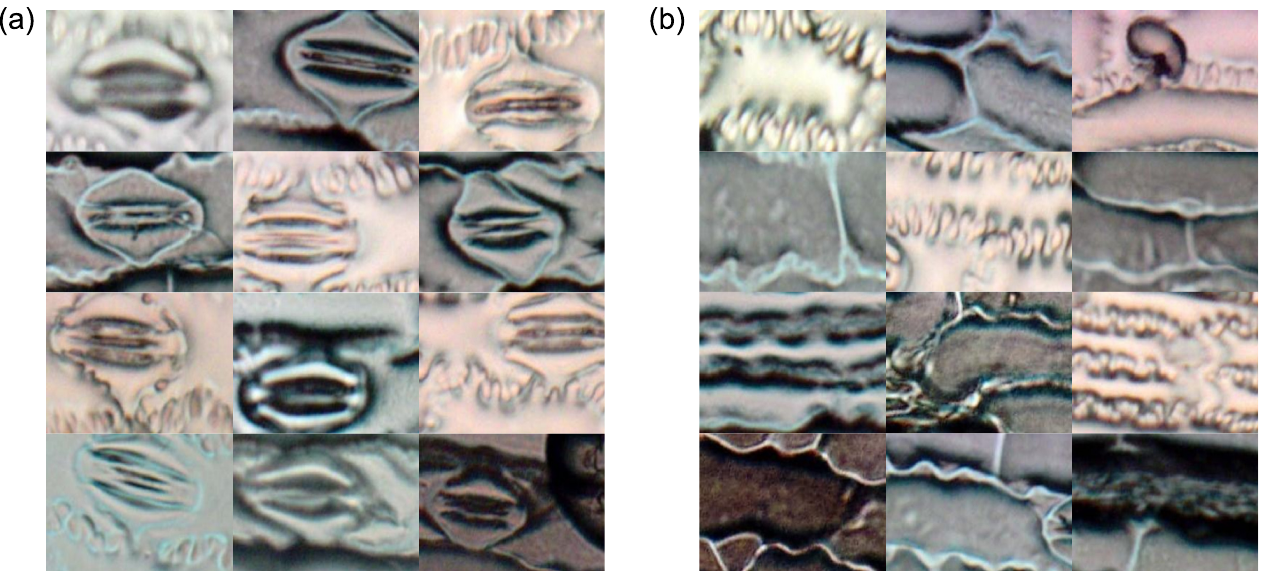
Fig 5. Examples of subimages/regions from the microscope images of maize cultivars corresponding to (a) stomata, and (b) non-stomata. These regions were manually selected and labeled in this work.